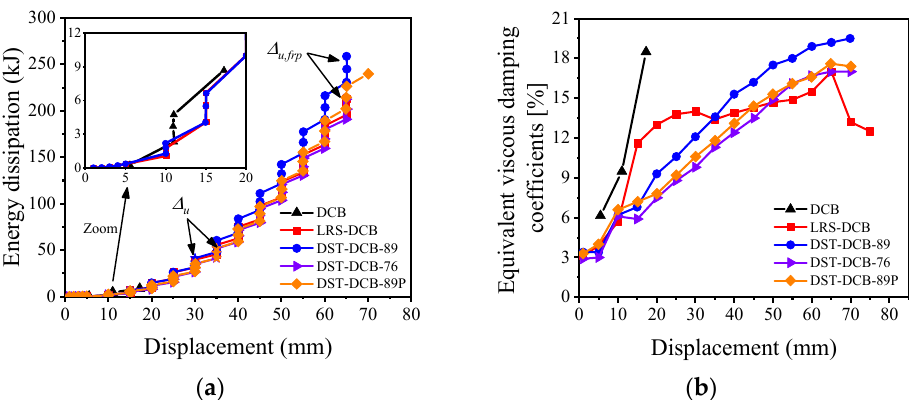
Figure 15. Analysis of energy dissipation: ( a ) cumulative energy dissipation; ( b ) equivalent viscous damping coefficients.